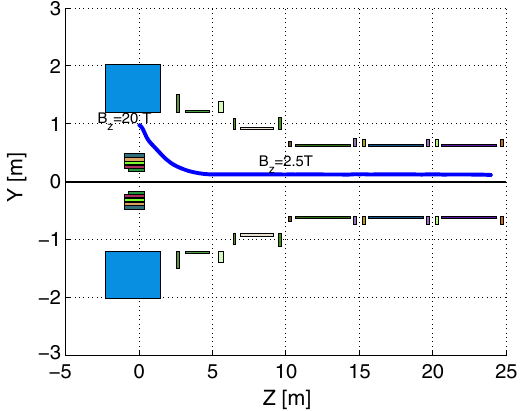
FIG. 11. Performance of the front end, in terms of accepted positive muons per 8 GeV proton on target, as a function of taper length. Curves are shown for target fields of 15 and 20 T, and final fields of 1.5, 2.0, and 2.5 T.